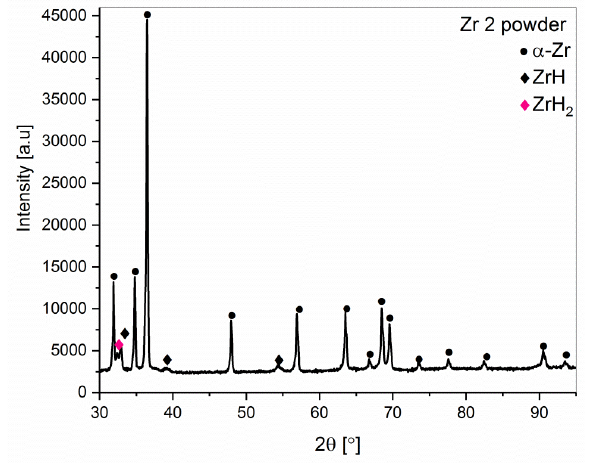
Figure 3. The XRD pattern of the Zr 2 powder (98.8% purity).